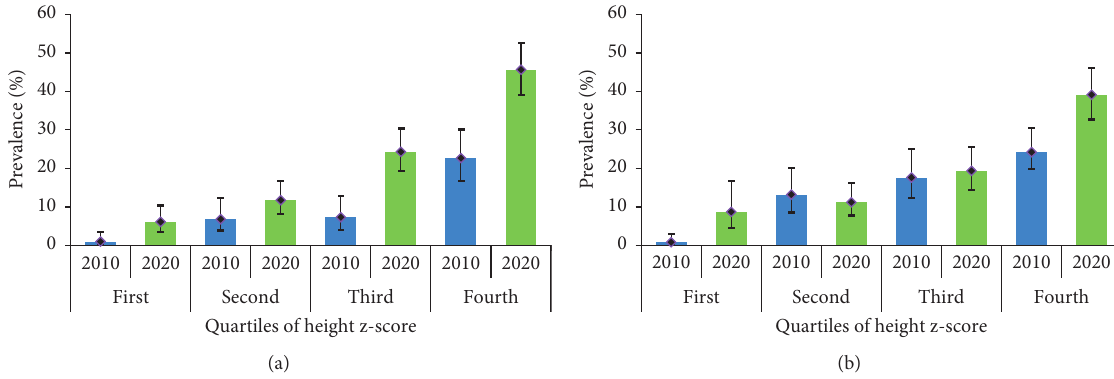
Figure 4: Adjusted prevalence (%, 95% CI) of central overweight/obesity across quartiles of height z-score in males (a) and females